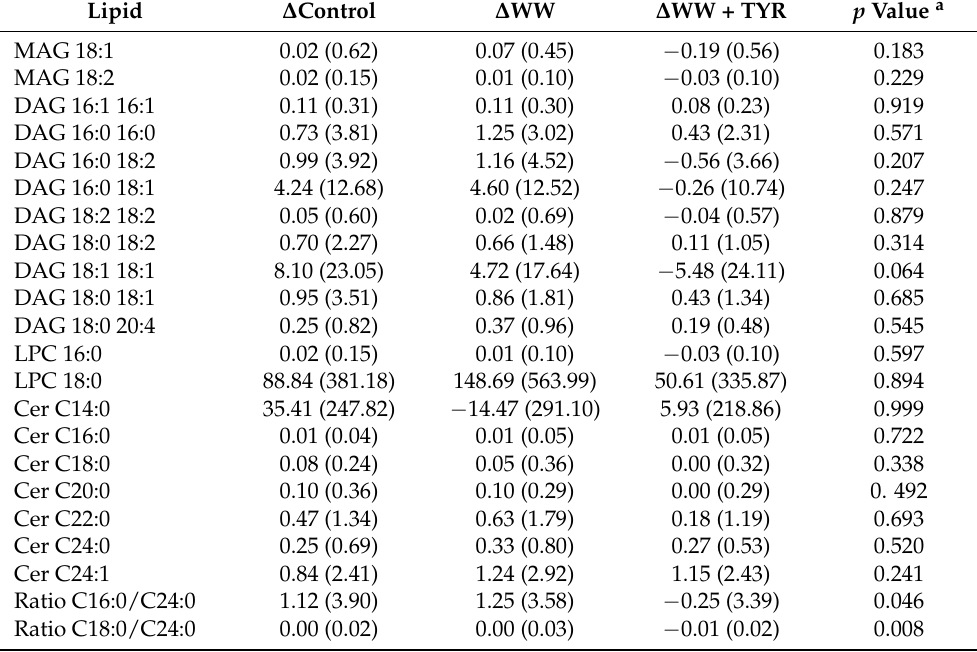
Table A3. Changes in the lipidomic profile ( ∆ : final vs. baseline) following the 4-week control, WW, and WW + TYR interventions 1